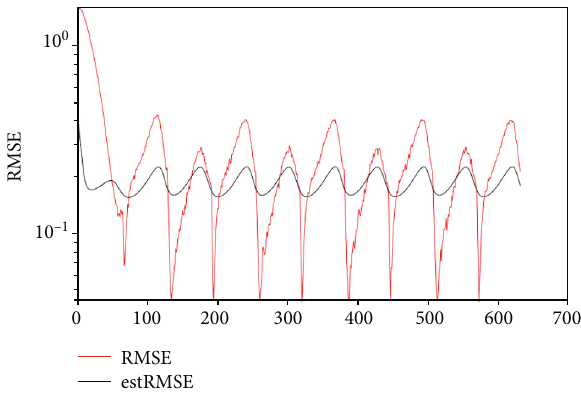
Figure 8: State estimation results after multi-step feedback predictive control.